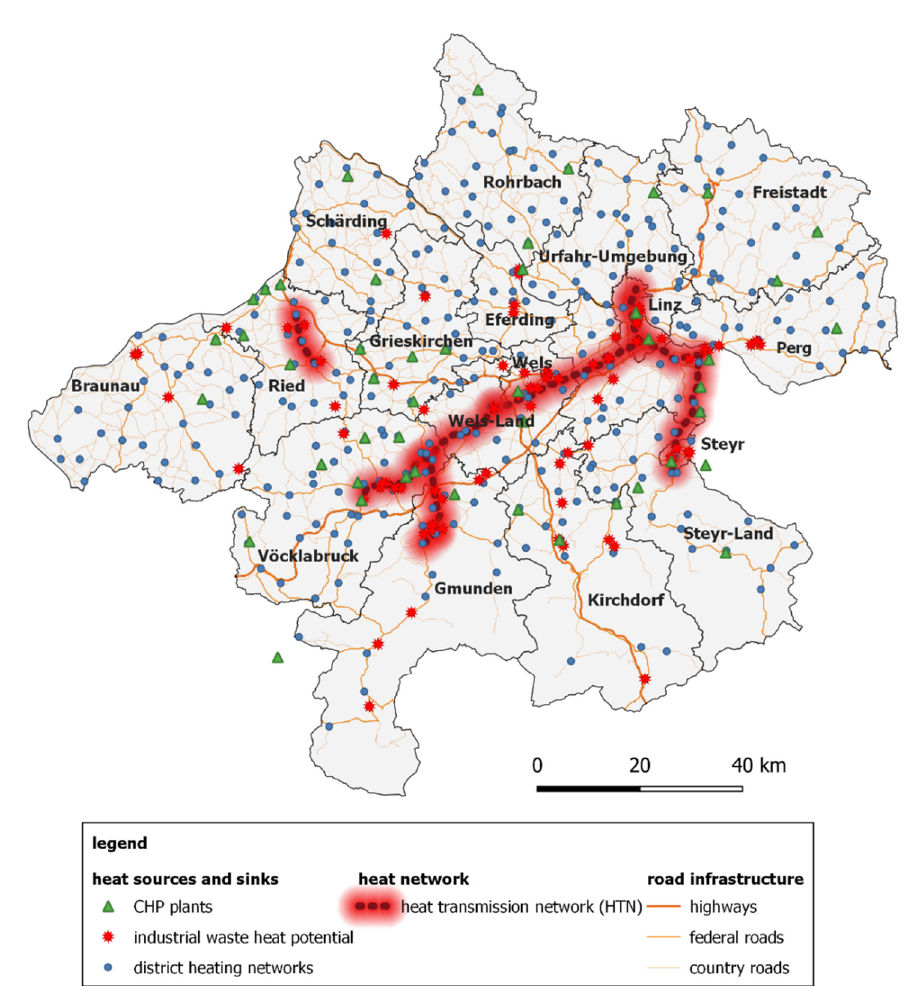
Figure 2. Case study results: possible routing of a SR-DHN in Upper Austria [31].